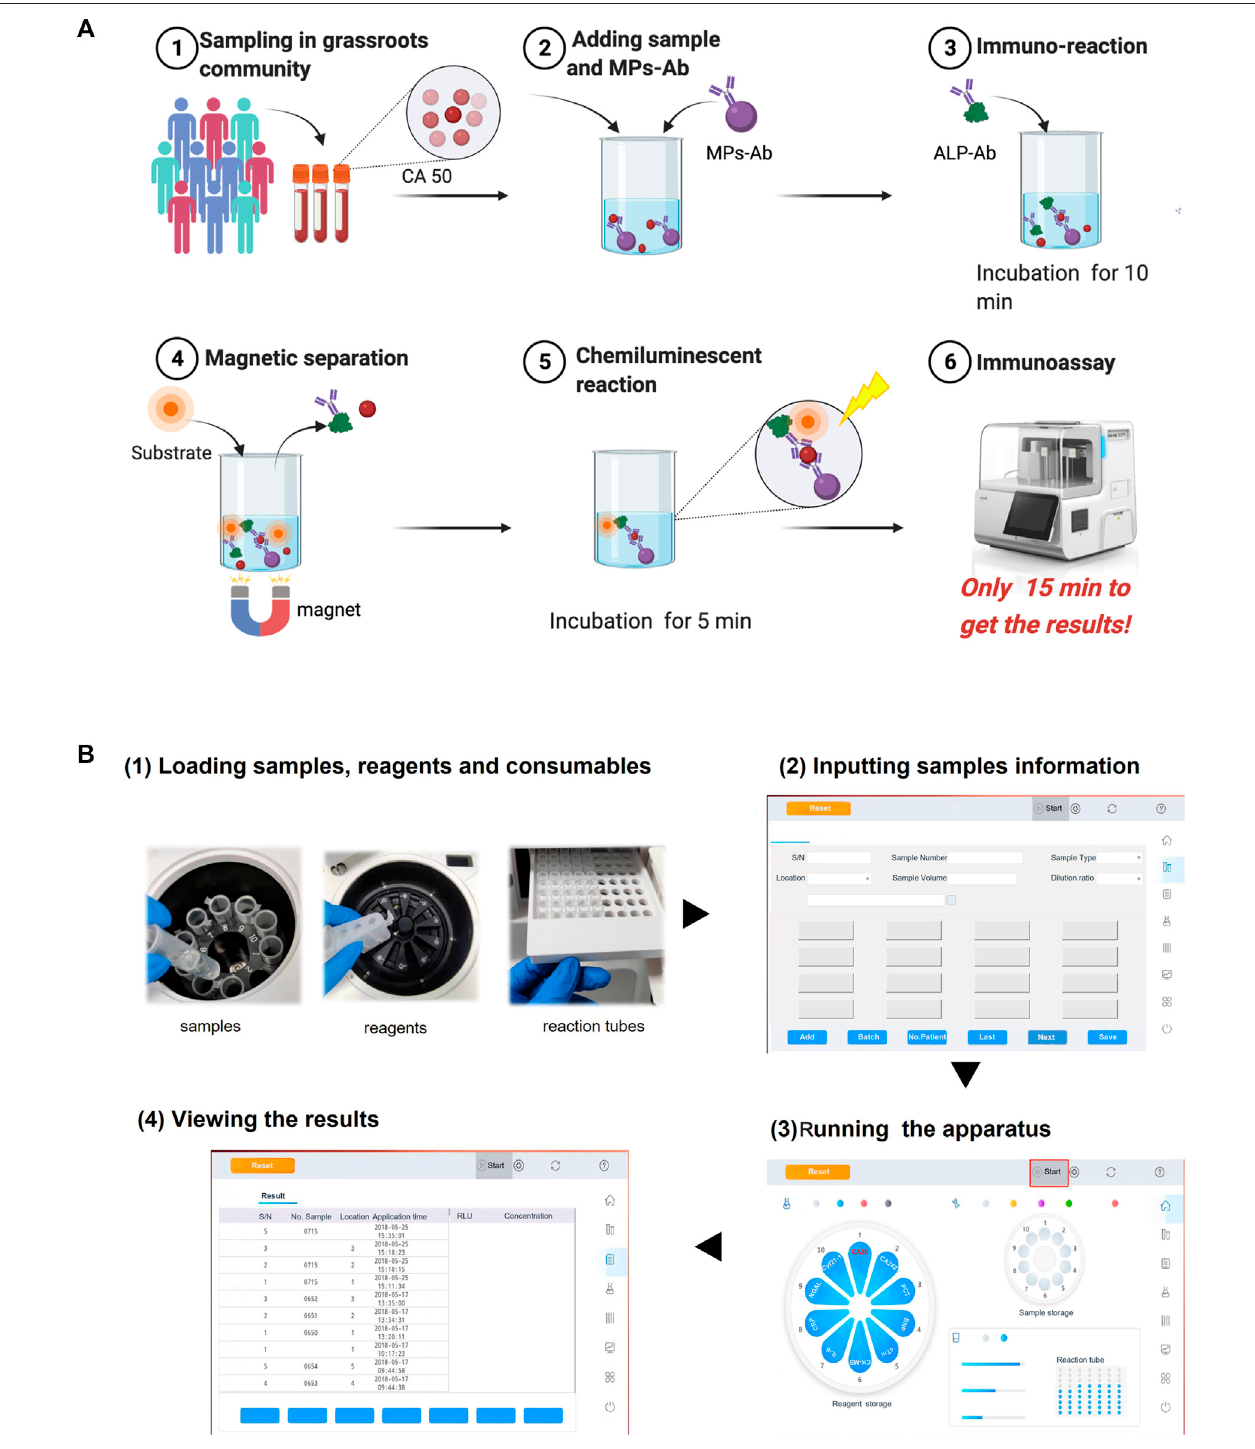
FIGURE 2 | Schematic illustration of the proposed POC-CLIA for CA50 detection (A) and the operation procedure of the miniaturized analyzer for users (B) .